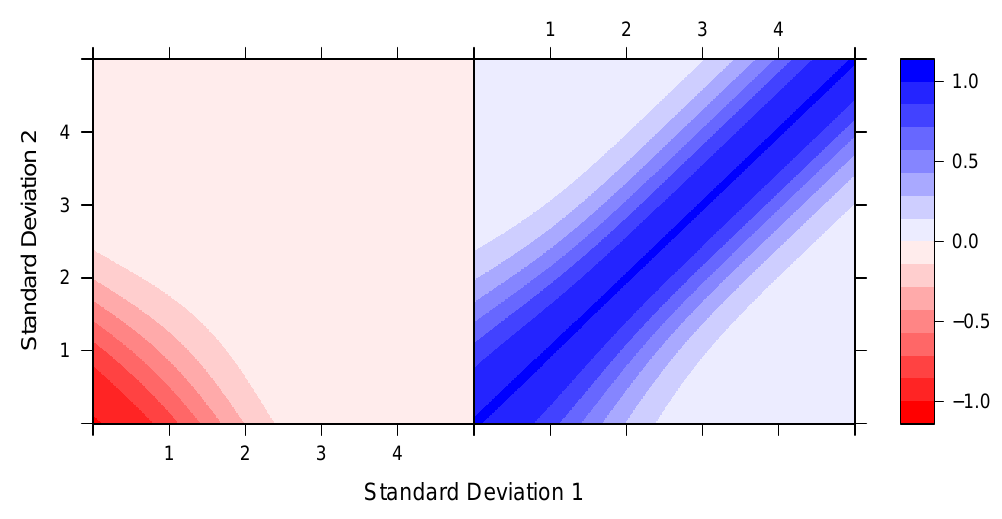
Figure A1. Lower ( left ) and upper ( right ) bound for correlations in a Gaussian-copula model with Log-Normal marginal distributions, as a function of the scale parameters σ 1 and σ 2